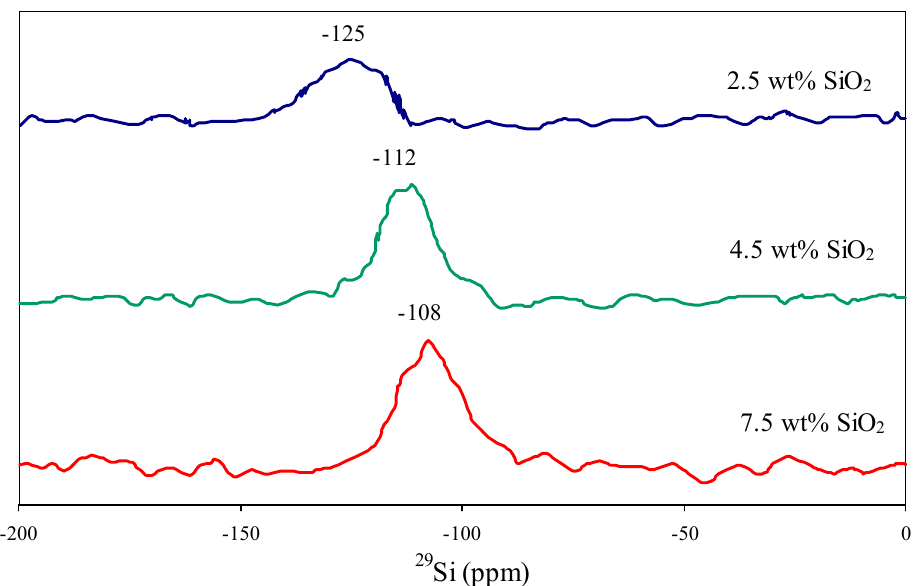
Figure 5. 29 Si Magic Angle Spinning Nuclear Magnetic Resonance (MAS NMR) spectra of SiO 2 ‐ modified supports.